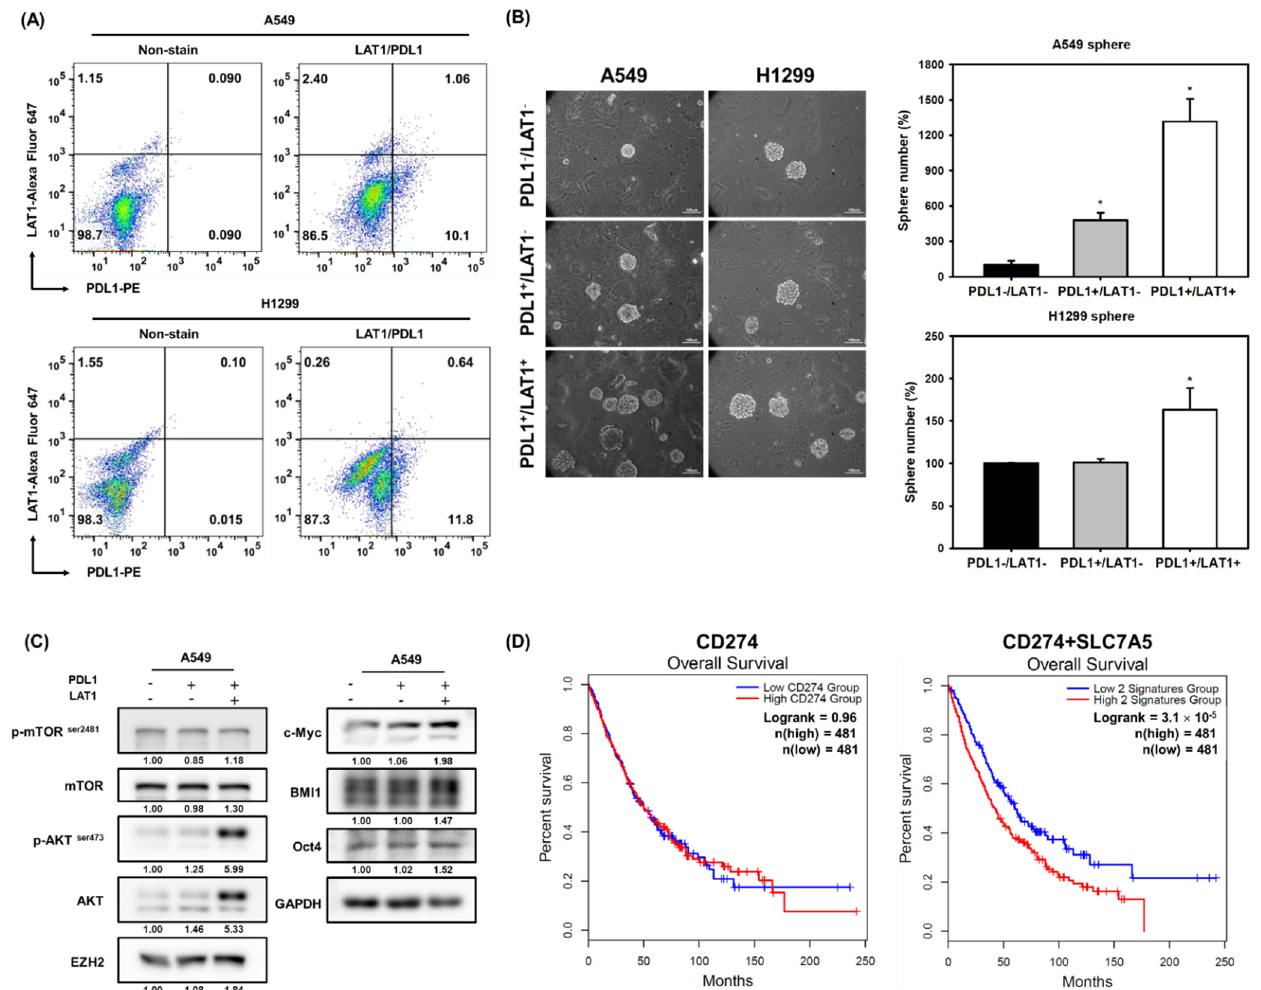
Figure 6. LAT1 + /PD-L1 + enriches CSC activity of NSCLC cells. ( A ) The cell surface expressions of LAT1 and PD-L1 on A549 and H1299 cells were determined by FACS with fluorescence-labeled antibodies. ( B ) Three populations of NSCLC cells (PD-L1 − /LAT1 − , PD-L1 + /LAT1 − , PD-L1 + /LAT1 + ) were isolated by FACS cell sorting, and their CSC activities were measured by tumorsphere cultivation. Pictures were presented at 100 × magnification and the inserted scale bars indicate 100 µ m in length. The data were presented as relative percentages of the tumorsphere number of PD-L1 − /LAT1 − cells. * p < 0.05. ( C ) The expressions of cancer stemness proteins (BMI1, c-MYC, EZH2, OCT4), phosphor-mTOR ser2481 , mTOR, phosphor-Akt ser473 , and Akt were determined by Western blot. The inserted numbers indicated relative expression levels in comparison to PD-L1 − /LAT1 − cells after normalization to GAPDH. ( D ) The overall survival curves of NSCLC patients in the TCGA database regarding expression levels of CD274 and the two-gene signature of CD274 and SLC7A5 using median level as the cutoff criteria were analyzed using the GEPIA2 webtool [18].